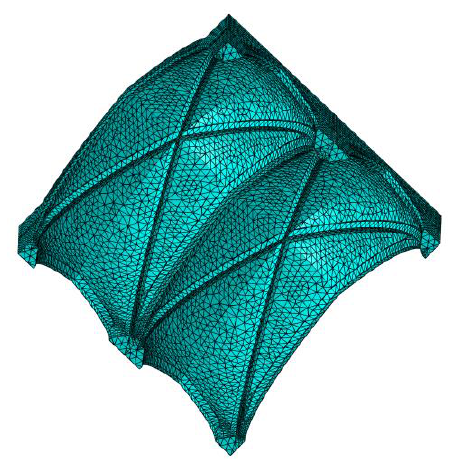
Figure 7. Vault in Milan cathedral. Mesh with tetrahedral elements for numerical simulations